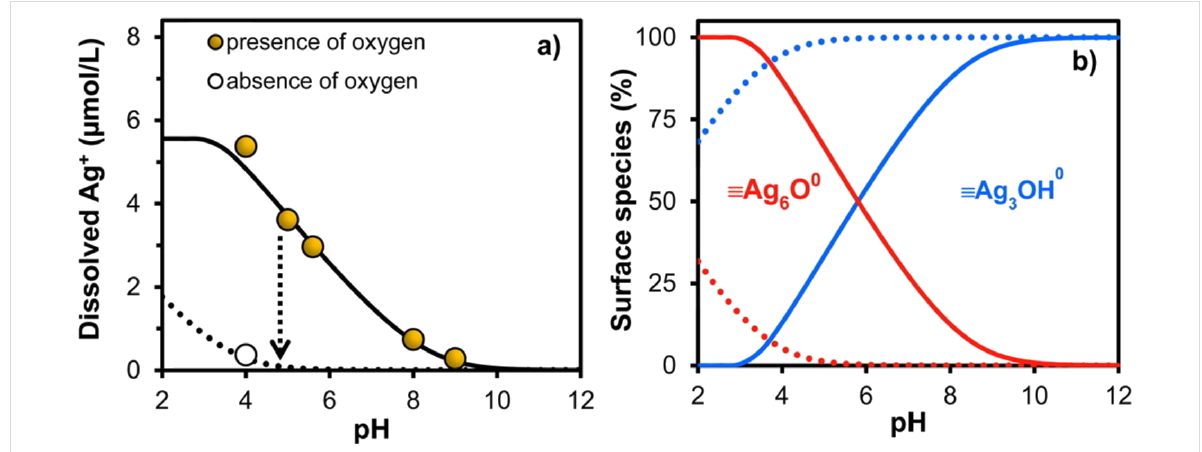
Figure 3: (a) Ag + release after one day of reaction in the presence of oxygen. The dotted arrow indicates decreased Ag + release when AgNPs is Ar-purged. In this case, there is no dissolved oxygen available for oxidative release. (b) Speciation curve for the formation of Ag 6 O 0 and Ag 3 OH 0 species as a function of pH. The dotted lines refer to a system without oxygen. Reprinted with permission from [57], Copyright 2015 American Chemi- cal